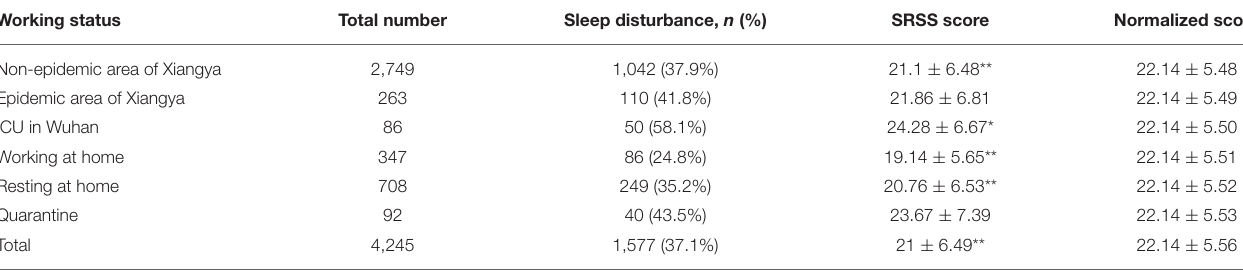
TABLE 2 | The prevalence rates of sleep disturbance and SRSS scores compared with the norm. Working status Total number